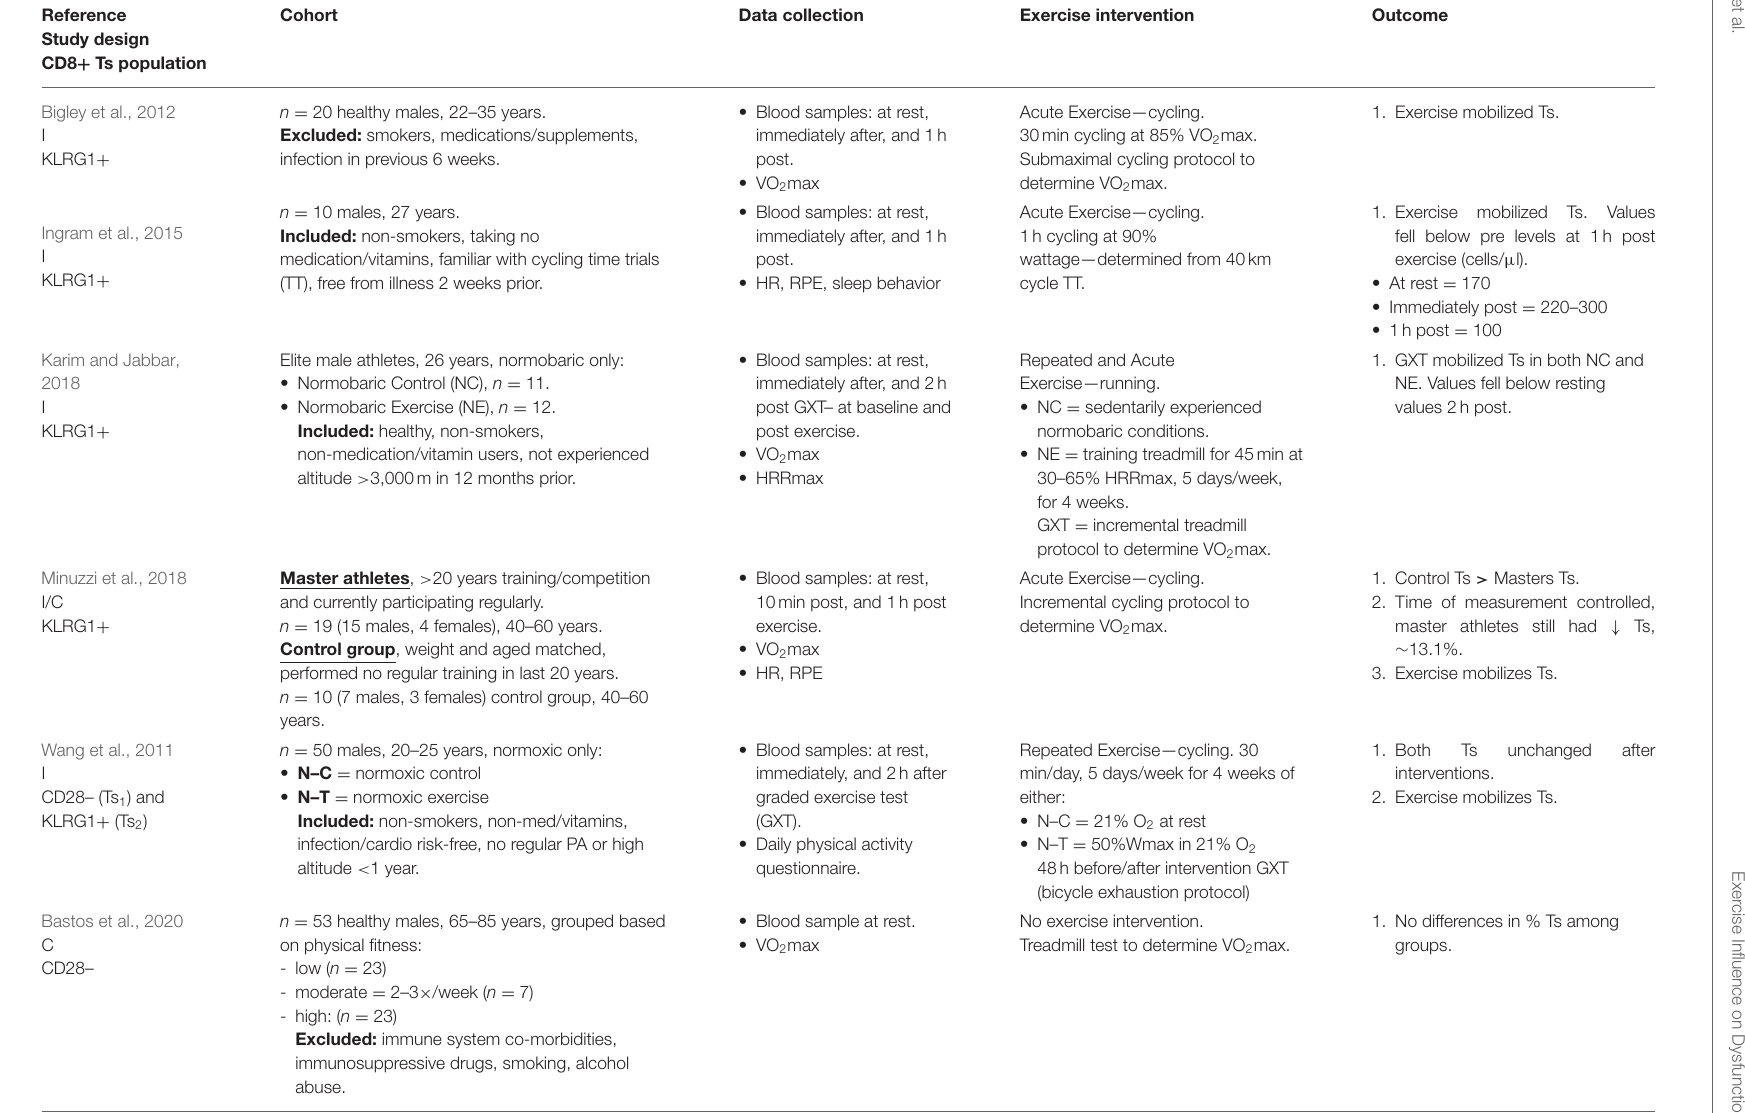
TABLE 2 | Summary of results detailing the influence of exercise on senescent T (Ts) cells from studies included in this systematic